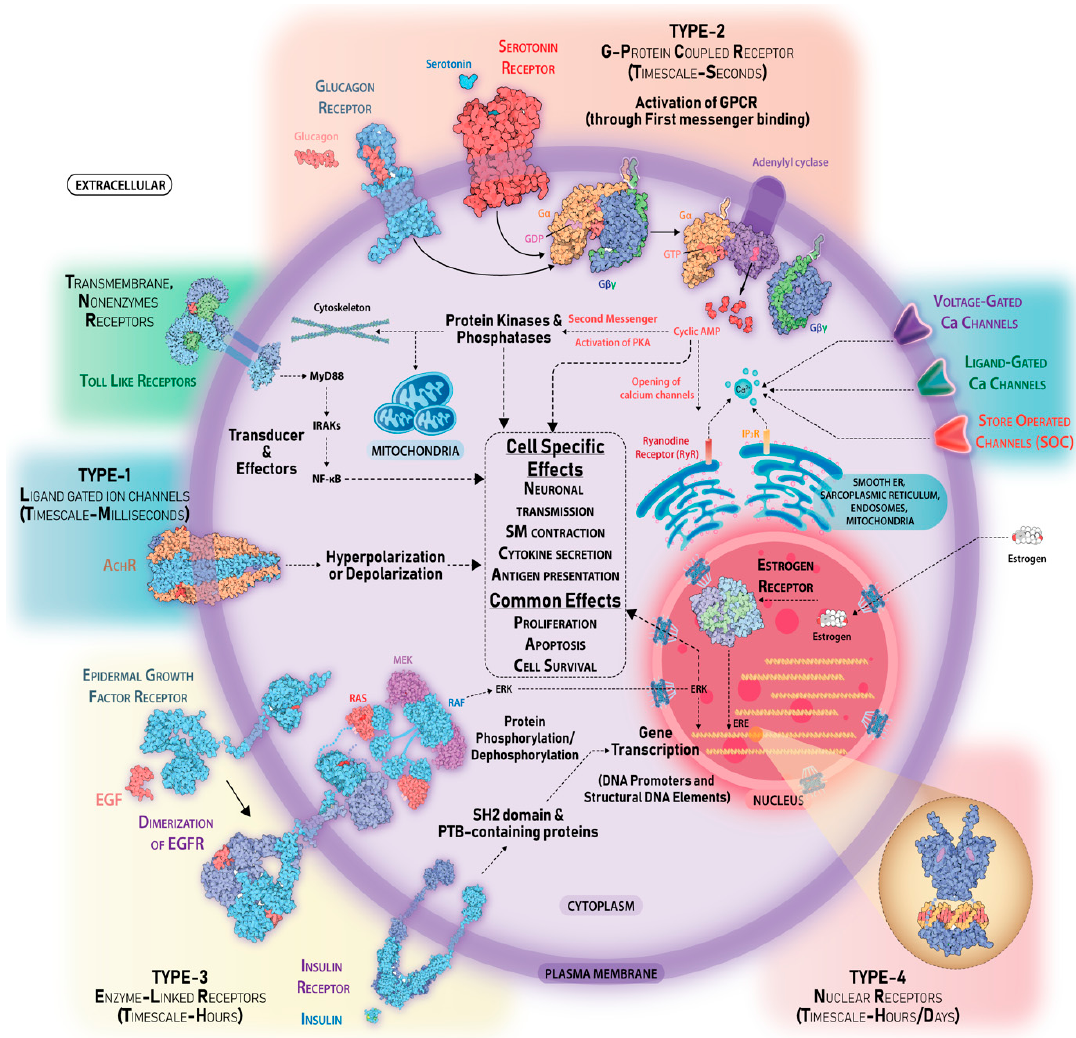
Figure 2. A holistic view of the various cell-surface and intracellular receptors, their associated intracellular components, and downstream effects (Note—Receptors and protein structures are intracellular components, and downstream e ff ects (Note—Receptors and protein structures are adapted adapted from PDB-http://pdb101.rcsb.org). from PDB-http: //